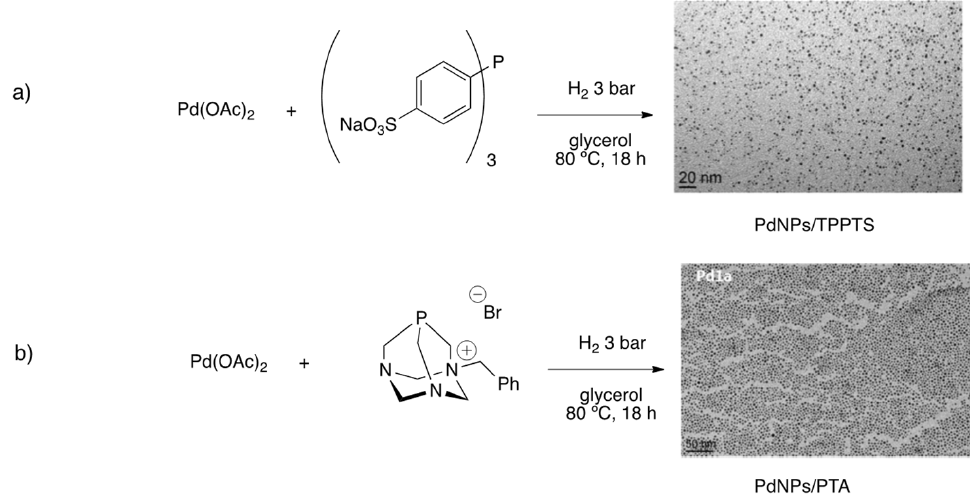
Figure 10. Synthesis of PdNPs in glycerol stabilized by different ligands: TPPTS ( a ) and PTA ( b ) [122,123]. Reproduced from [122] with permission from Wiley and from [123] with permission from Elsevier.